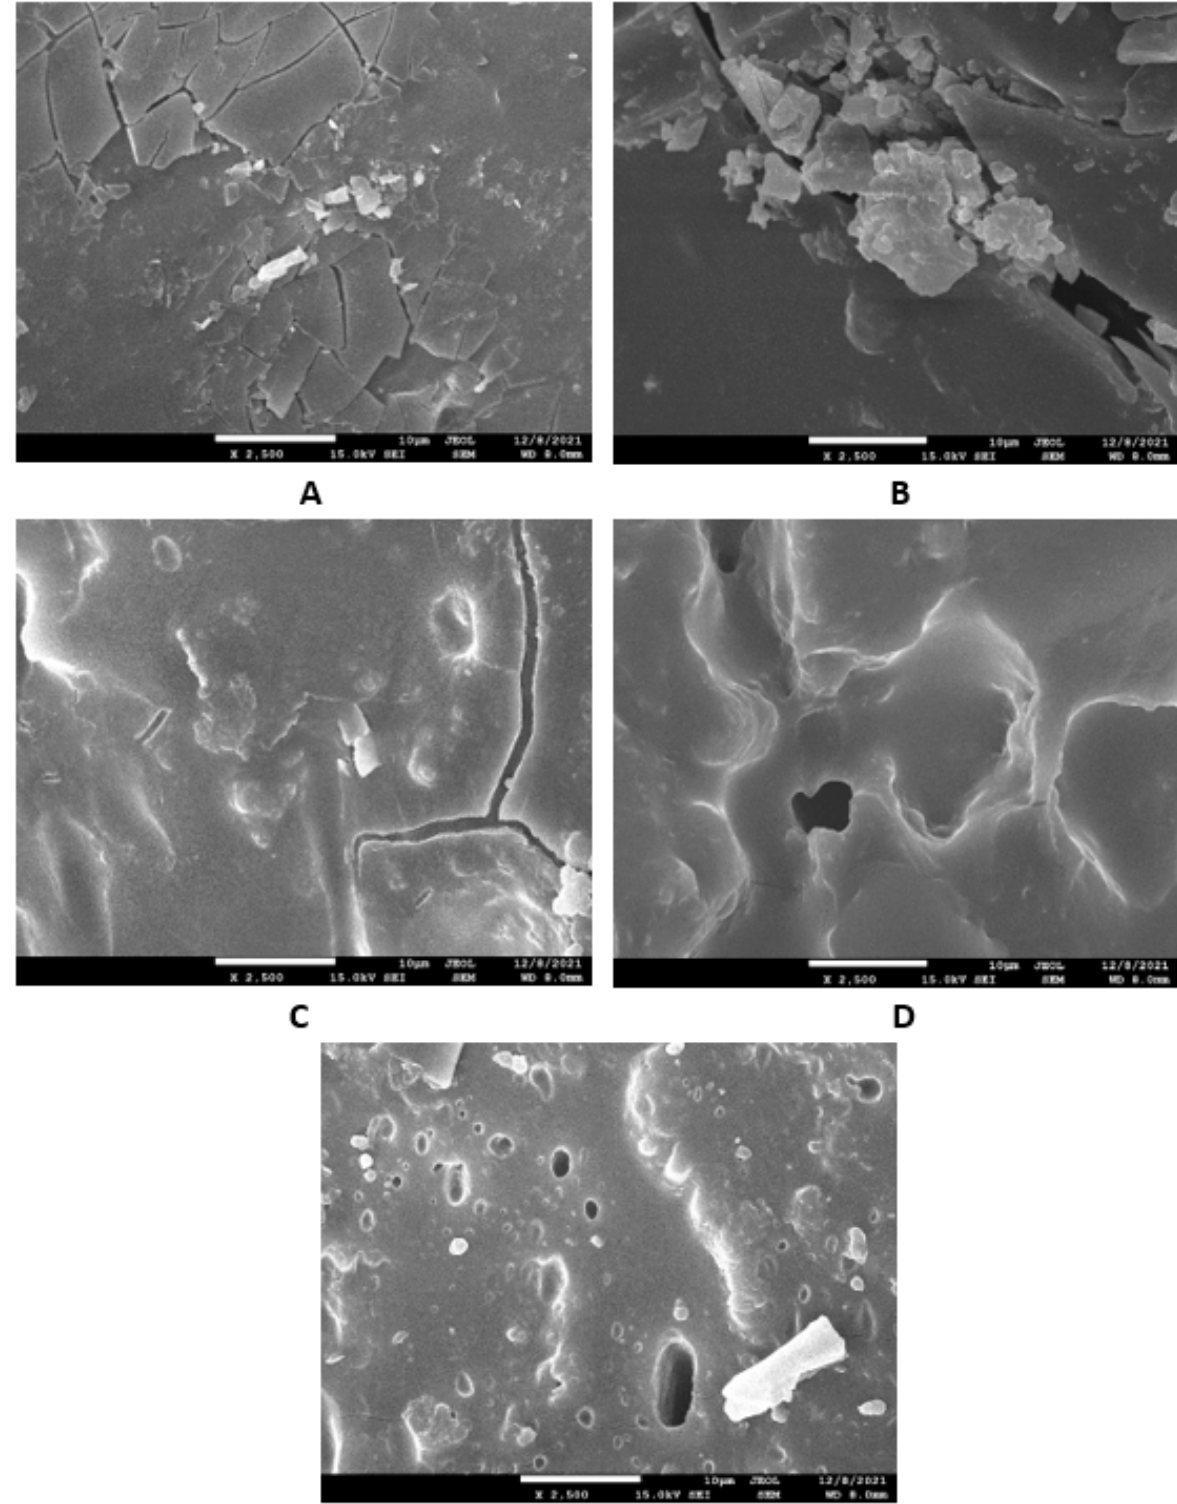
Figure 15. SEM images of vulcanizates based on SBR: ( A ) reference vulcanizate without glycerol, ( B ) vulcanizate with 5 phr of glycerol, ( C ) vulcanizate with 10 phr of glycerol, ( D ) vulcanizate with 15 phr of glycerol, and ( E ) vulcanizate with 20 phr of glycerol.